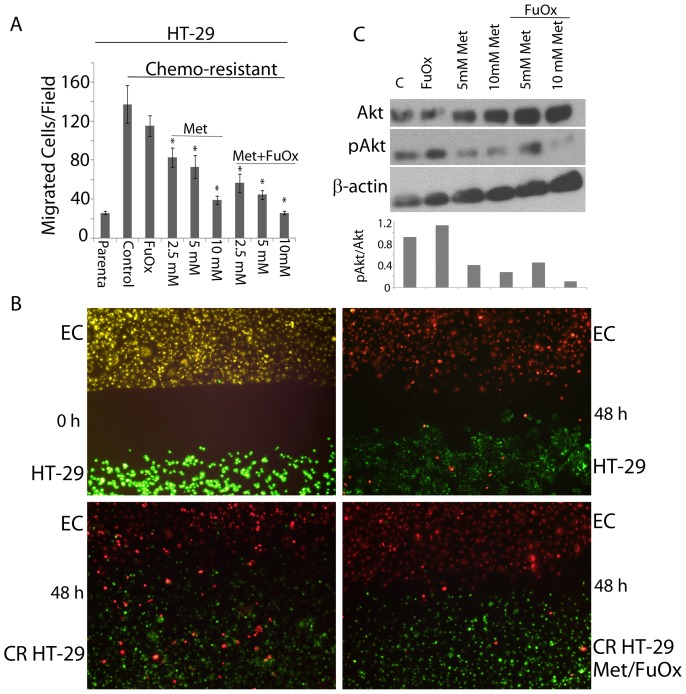
Boyden chamber analysis of migration of parental and CR HT-29 cells.Metformin/FuOx treatment reduced the migration of CR HT-29 cells. Each point represents an average of 6 readings. Bars represent mean ± standard deviation (A). Wound healing assay using endothelial (top/red) and CRC (bottom/green). Top left panel: wound at 0 hr; bottom left panel: complete wound healing at 48 hr in CR HT-29 cells; top right panel: partial wound healing in HT-29 cells after 48 hr; bottom right panel: incomplete wound healing in CR HT-29 cells in the presence of 5 mM metformin/FuOx at 48 hr (B). Western blot analysis of metformin/FuOx treated CR H29 cells indicating decreased pAkt levels (C); relative changes in phospho-Akt (pAkt) were calculated as a ratio of pAkt/Akt after normalization to β-actin, which was used as loading control. *p<0.05.